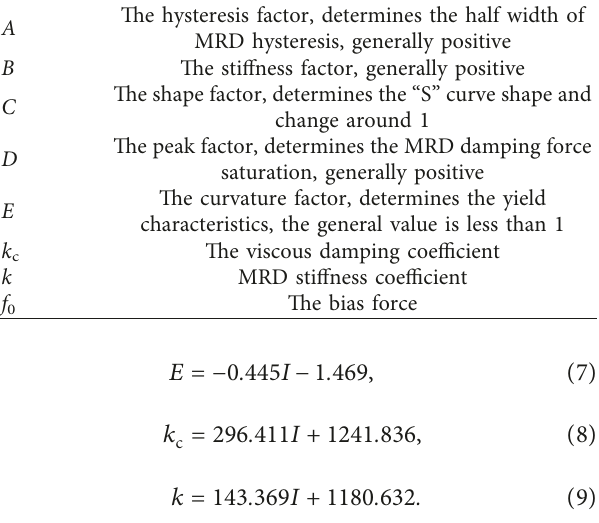
Table 1: Parameters’ definition and the range of their